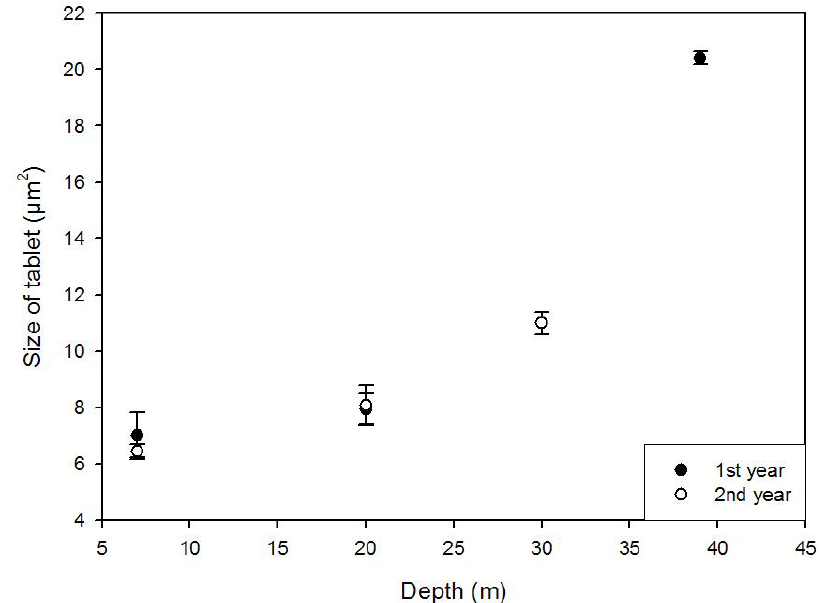
Figure 7. Size of tablets (µm 2 ) as a function of depth (m). The error bars represent the standard deviation of the tablet size. We analyzed 5 shells for each depth and measured 10 points in each